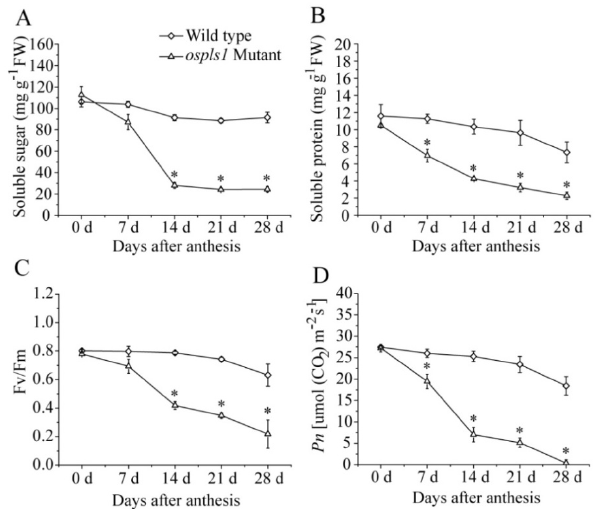
Figure 2. Temporal patterns of soluble sugar ( A ), soluble protein ( B ), Fv/Fm ( C ), and Pn ( D ) in flag leaves of the two rice genotypes during the grain-filling stage. Vertical bars represent standard errors with three independent biological replications. The asterisks represent significant differences ( p < 0.05).